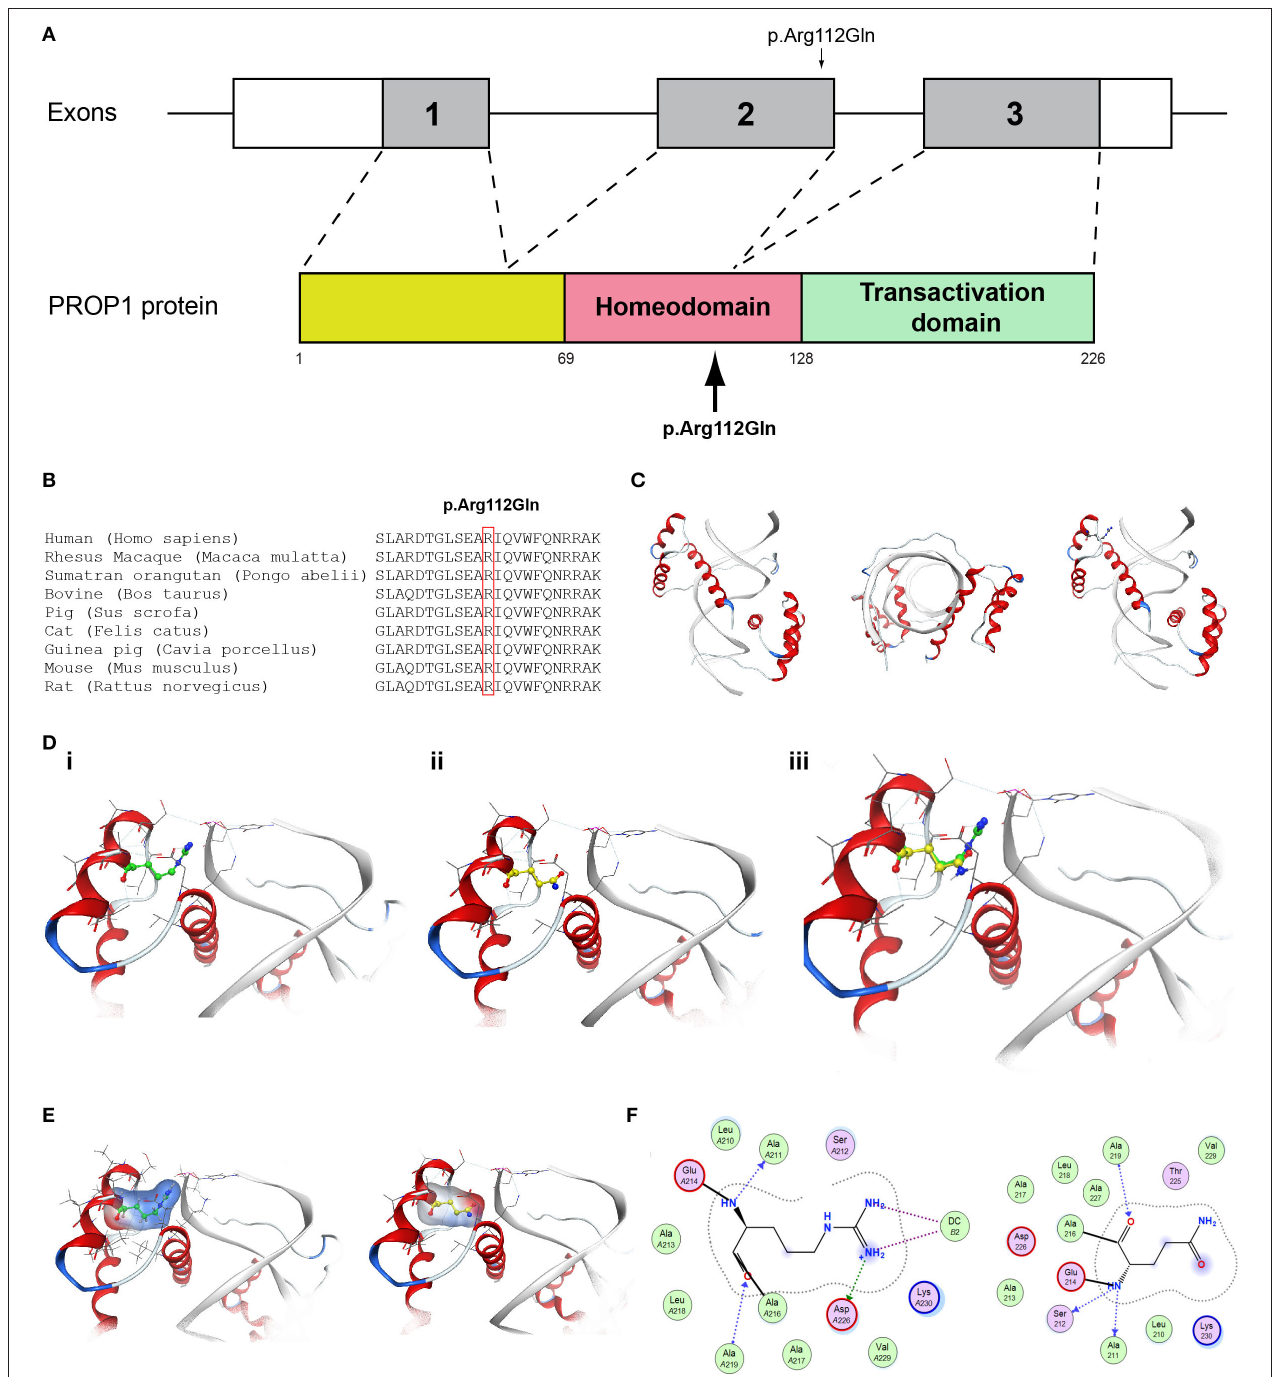
FIGURE 7 | Identification of the p.Arg112Gln PROP1 variant. (A) Schematic representation of the PROP1 gene and protein. The p.Arg112Gln PROP1 variant is indicated with arrows. (B) Multiple sequence alignment of the amino acid at position 112 of the PROP1 protein from various species. The conserved arginine amino acid at position 112 is indicated by red color. (C) The homology model for PROP1. (D) Design of the wild type (i) and mutant model (ii) of PROP1. (iii) Wild type and mutant models superposed. (E) Electrostatic surface calculated and drawn for the wild type and mutant models. (F) 2D interaction diagram for wild type and mutant